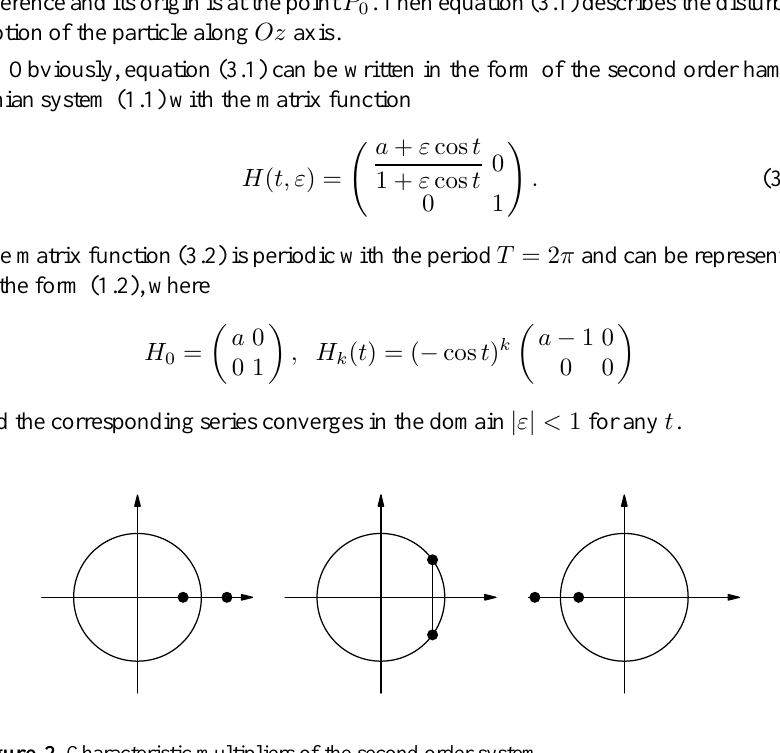
Figure 2. Characteristic multipliers of the second order